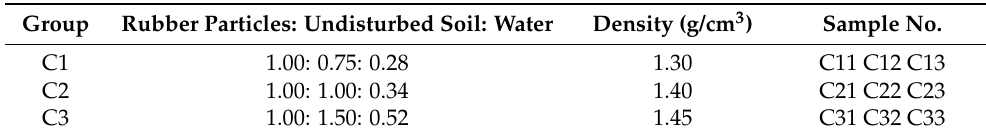
Table 4. Group D: 0.2–0.8 mm quartz sand + sawdust (sawdust sand). Table 2. Group B: rubber powder + undisturbed soil (rubber powder soil). Group Quartz Sand: Sawdust: Water Density (g/cm 3 ) Sample No. Rubber Powder: Undisturbed Group Soil: Water